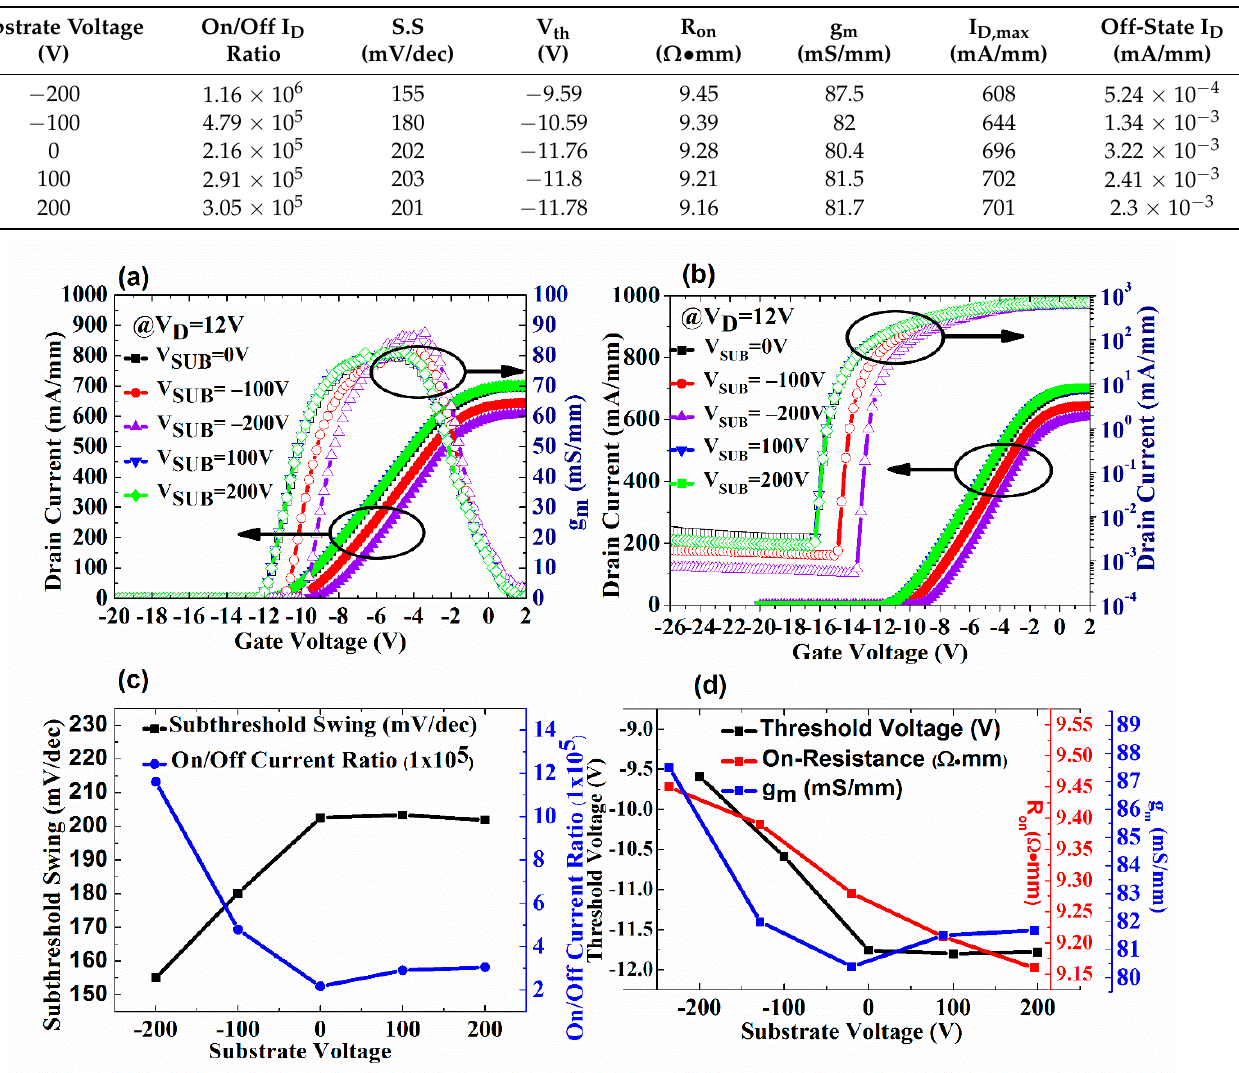
Table 1. DC characteristics of the GaN-on-Si HEMT with different substrate voltages.